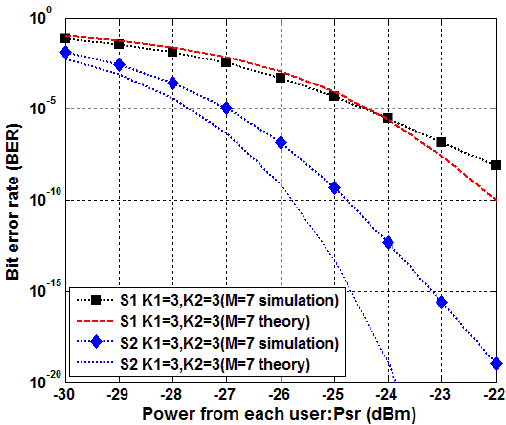
Figure 4. Bit-error rate (BER) comparison between numerical and simulation results for Classes 1 and 2.